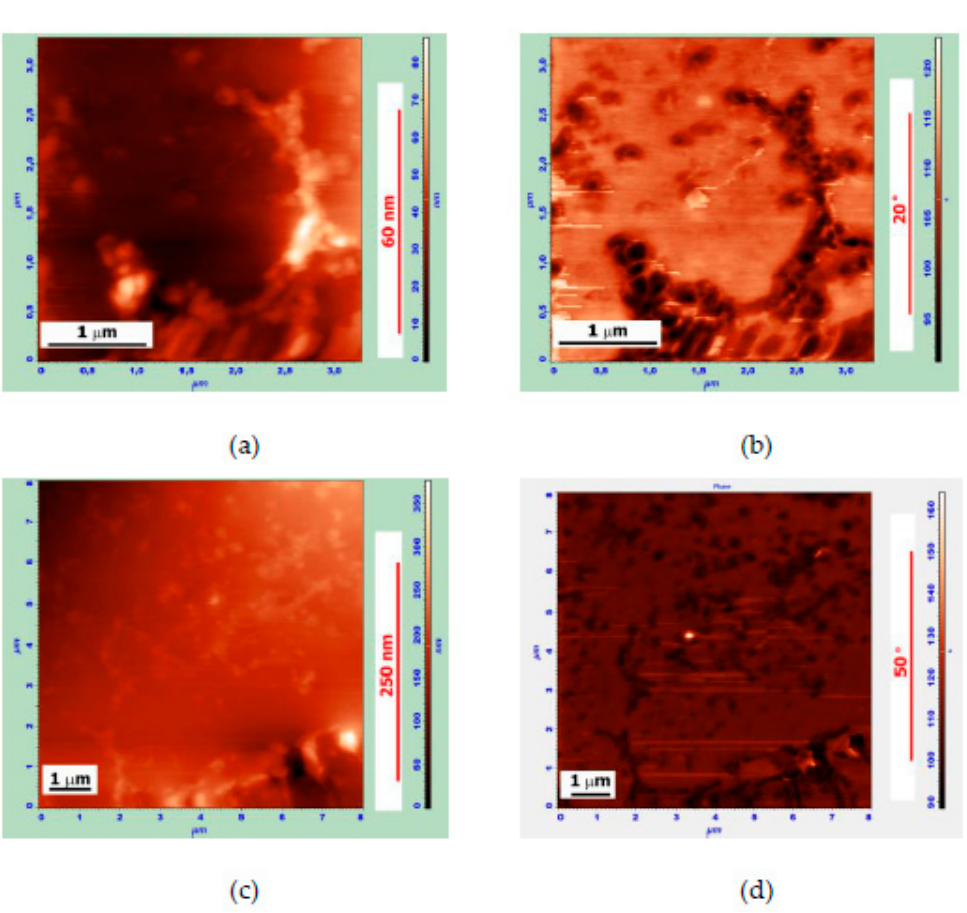
Figure 4. AFM images of the MB surface with the gel structure area. Topography (left), phase image (right): ( a , b )—3 × 3 μ m, ( a ) Z-coordinate—85 nm; ( c , d )—8 × 8 μ m, ( c ) Z-coordinate—375nm.